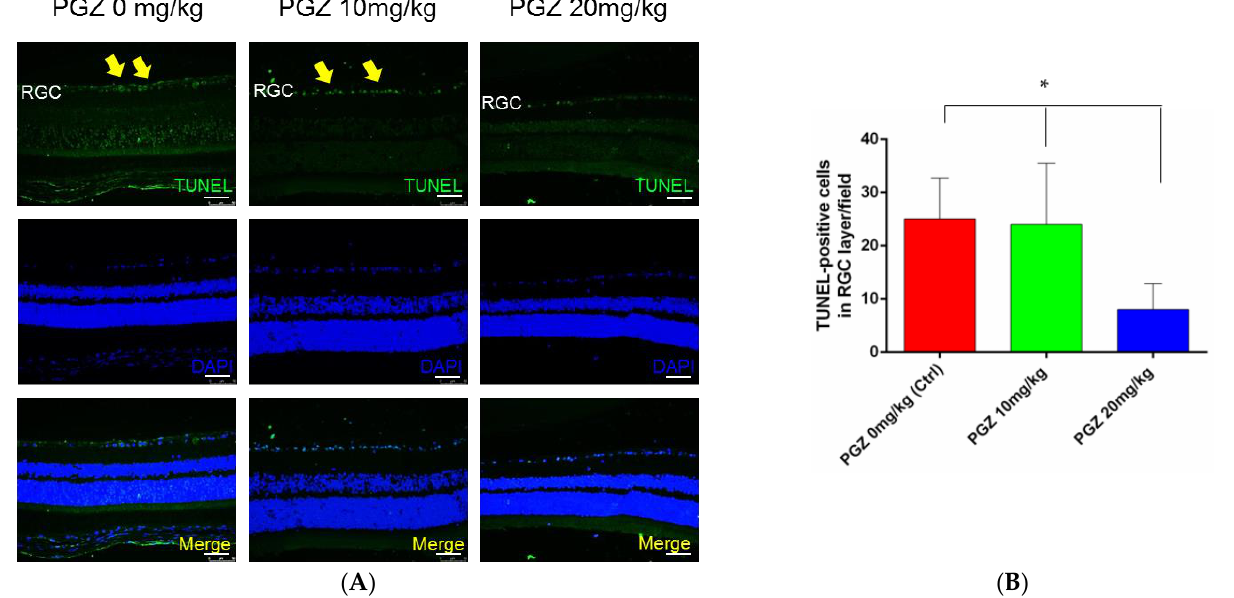
Figure 3. Apoptosis in RGCs 1 week after AION in DM mice. ( A ) Apoptosis in RGCs was evaluated through TUNEL staining. After ischemic optic neuropathy, apoptotic cells (yellow arrows) in RGCs were fewer in diabetic mice treated with 20 mg/kg PGZ than in those treated with 10 and 0 mg/kg PGZ (DMSO only). ( B ) Bar graph shows less apoptotic cells in RGCs in the retina of DM mice treated with 20 mg/kg PGZ compared with that in the other 2 groups (* p < 0.05) (scale bar: 75 μm; magnification: 200×).